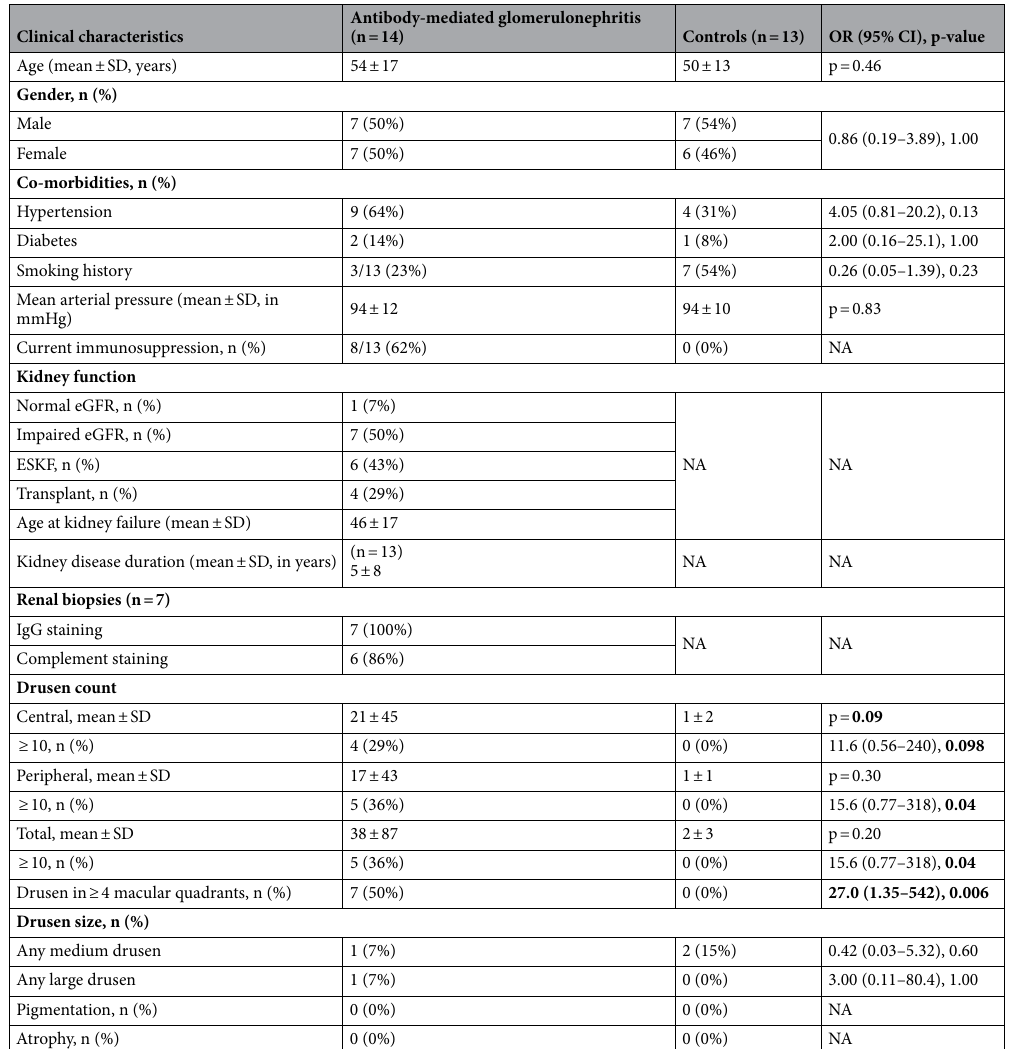
Table 3. Clinical features and drusen in antibody-mediated glomerulonephritis and controls. Significant values are in bold. Antibody-mediated glomerulonephritis includes membranous nephropathy and anti-GBM disease. CI confidence interval, eGFR estimated glomerular filtration rate mL/min/1.73 m 2 , IQR interquartile range, NA not